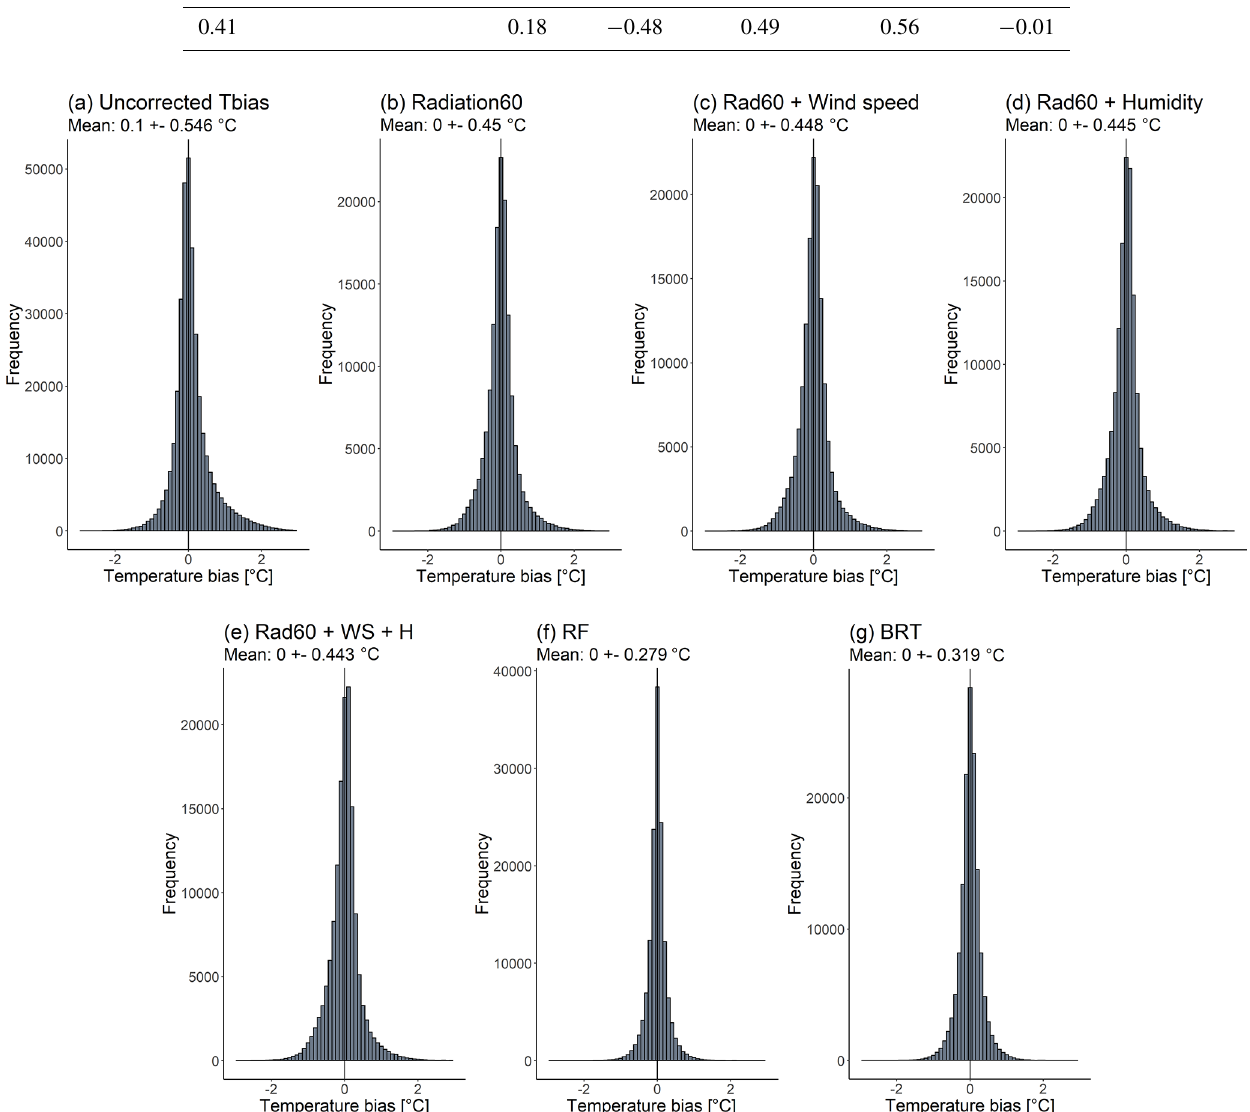
Figure 5. The uncorrected temperature bias (a) and the corrected temperature bias after validation with a simple linear regression with the past radiation (b) ; a multiple linear regression with the past radiation and wind speed (c) ; a multiple linear regression with the past radiation and humidity (d) ; a multiple linear regression with the past radiation, humidity and wind speed (e) ; and a random forest model (f) and a boosted regression trees model (g) including temperature, dew point temperature, humidity, radiation, radiation60, wind speed, altitude, month and hour. Mean biases and their standard deviations are given above the graphs. Note that the ranges on the y axis differ for the different